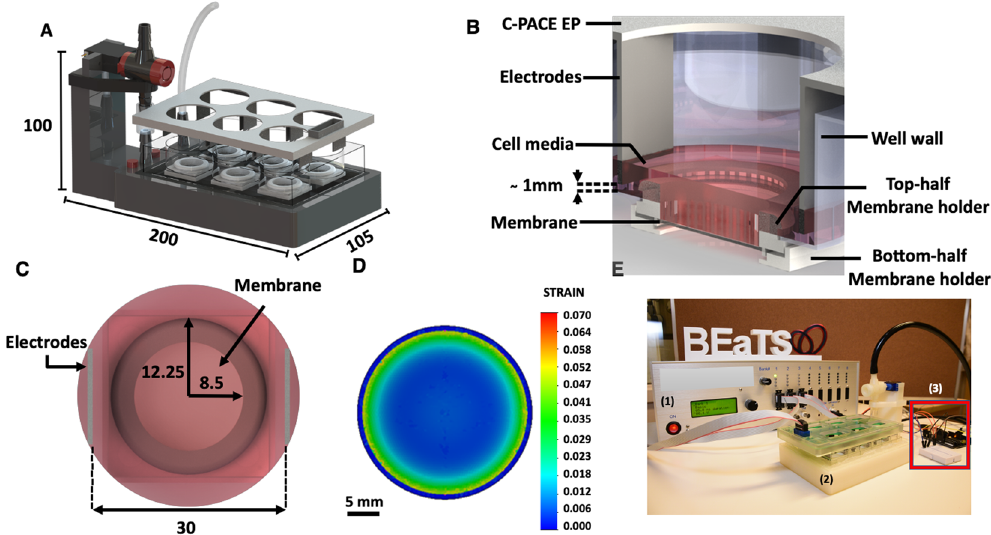
Figure 1. BEaTS- α a 3D Printed device for mechanical and electrical stimulation of cells in vitro . ( A ) Parts and components of the 3D printed stimulation device; Standard Tessellation Language (.stl) files for these, and all other 3D printed parts are accessible https://figshare.com/s/504b0f7ccbdc7b893e3a. ( B ) The bottom of the wells of a 6-well plate were removed and replaced by flexible, translucent silicone sheets. Cells were cultured on the membranes and mechanically stimulated by means of a vacuum-driven system. In addition, to simultaneously stimulate cells electrically, a C-PACE EP system was placed over the 6-well plate. The electrodes of the C-PACE EP system were inserted in the media and a TTL-controlled signal was sent to create a physiologically relevant cyclic stimulation cycle. ( C ) Top view of a well with the modified well bottom and the electrodes of the C-PACE EP system. Once assembled, the cells were seeded in a growth area of 2.26 cm 2 . ( D ) Finite Element Analysis (FEA) of the strain generated on the flexible membranes. A pressure of 55 kPa resulted in the deflection of the membranes with an average strain of 2.34%. FEA of the stress (Von Mises) and deflection (URES) profiles are shown in Fig. S1. ( E ) Actual image of the system assembled depicting the electrical impulse generator (1), mechanical stimulator (2), and Arduino UNO interface, red-boxed (3). All dimensions shown are in